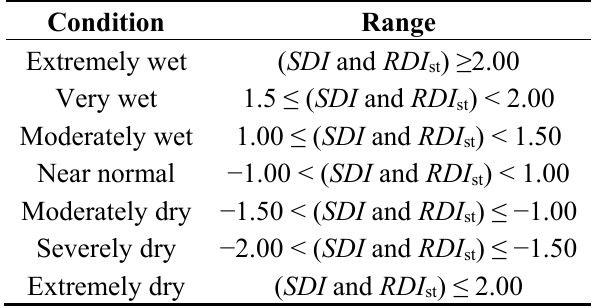
Table 1. Classification of drought conditions based on the standardized Reconnaissance Drought Index ( RDI st ) and Streamflow Drought Index ( SDI )